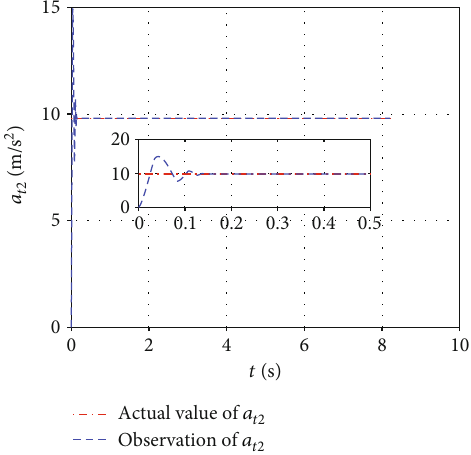
Figure 23: Dynamic error surfaces s